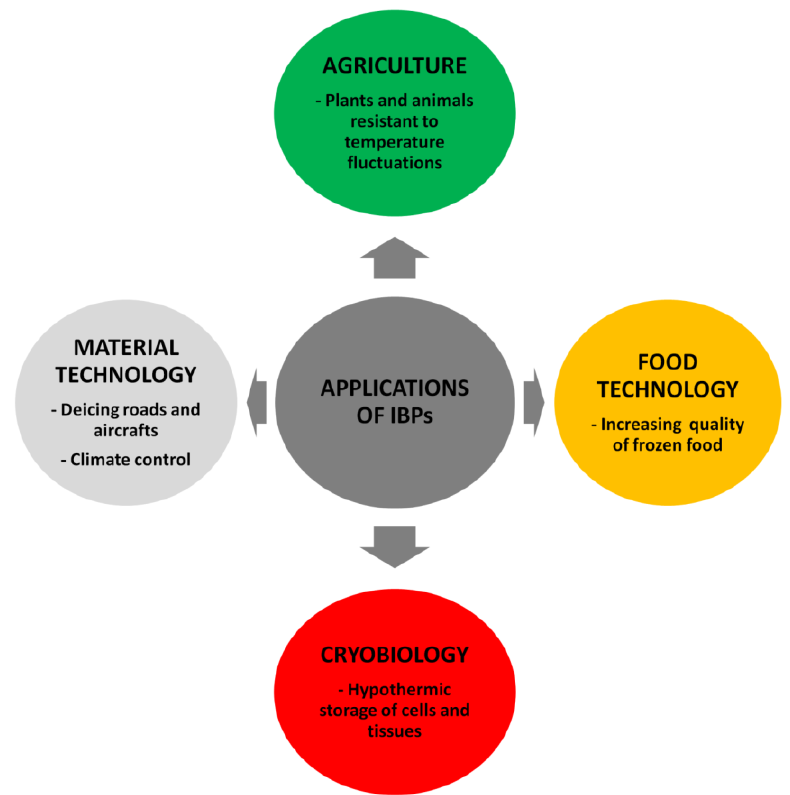
Figure 3. Applications of the ice binding proteins (IBPs) in different branches of industry.